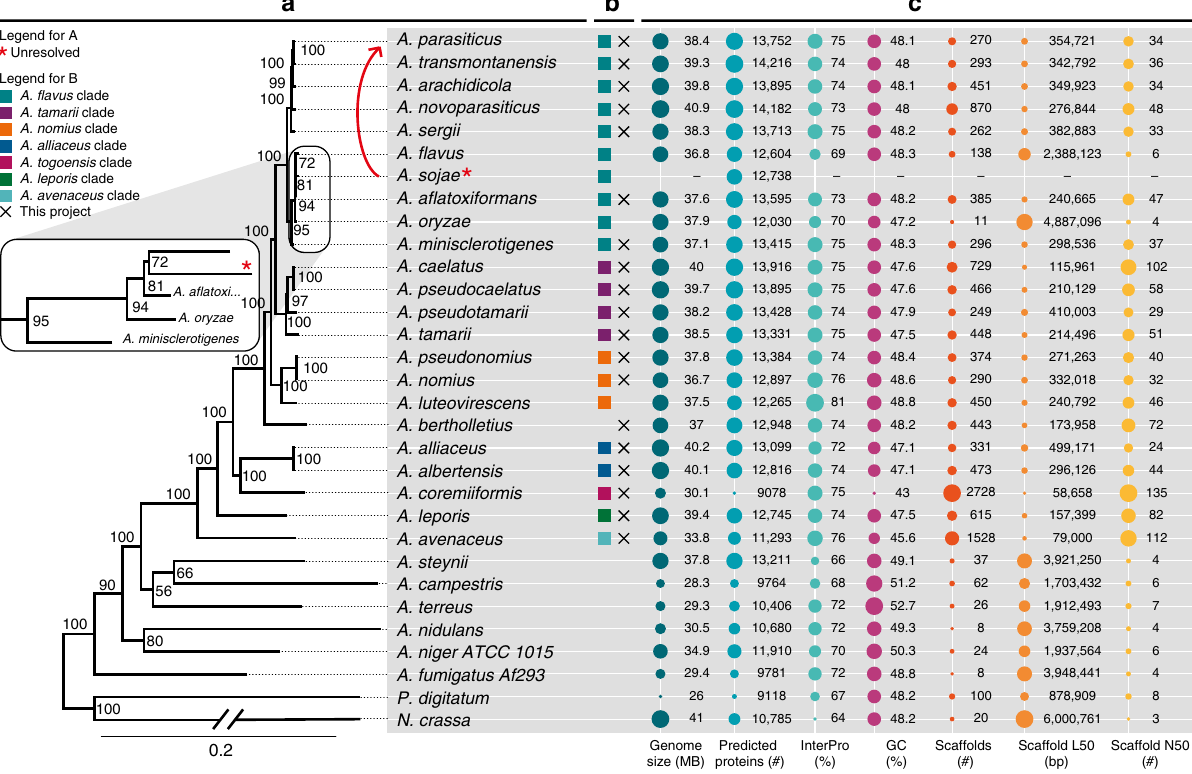
Fig. 1 Phylogeny and genome statistics of section Flavi plus eight other Aspergillus, Penicillium , and Neurospora species. a Phylogenetic tree constructed using RAxML, MUSCLE, and Gblocks based on 200 monocore genes (a single homolog in each of the species). The red star indicates an uncertain leaf most likely caused by a different gene calling method 98 – 100 , and the arrow shows where A. sojae should be placed in the phylogenetic tree. The zoom shows the branching in a clade around A. oryzae . b The colors illustrate the clades found within section Flavi and X indicates species sequenced in this study. Earlier sequenced genomes such as A. oryzae and A. fumigatus were assembled using optical mapping and genetic maps. c Seven bubble plots illustrating key genome numbers and sequencing quality parameter. The bubble sizes have been scaled to each panel and are not comparable across